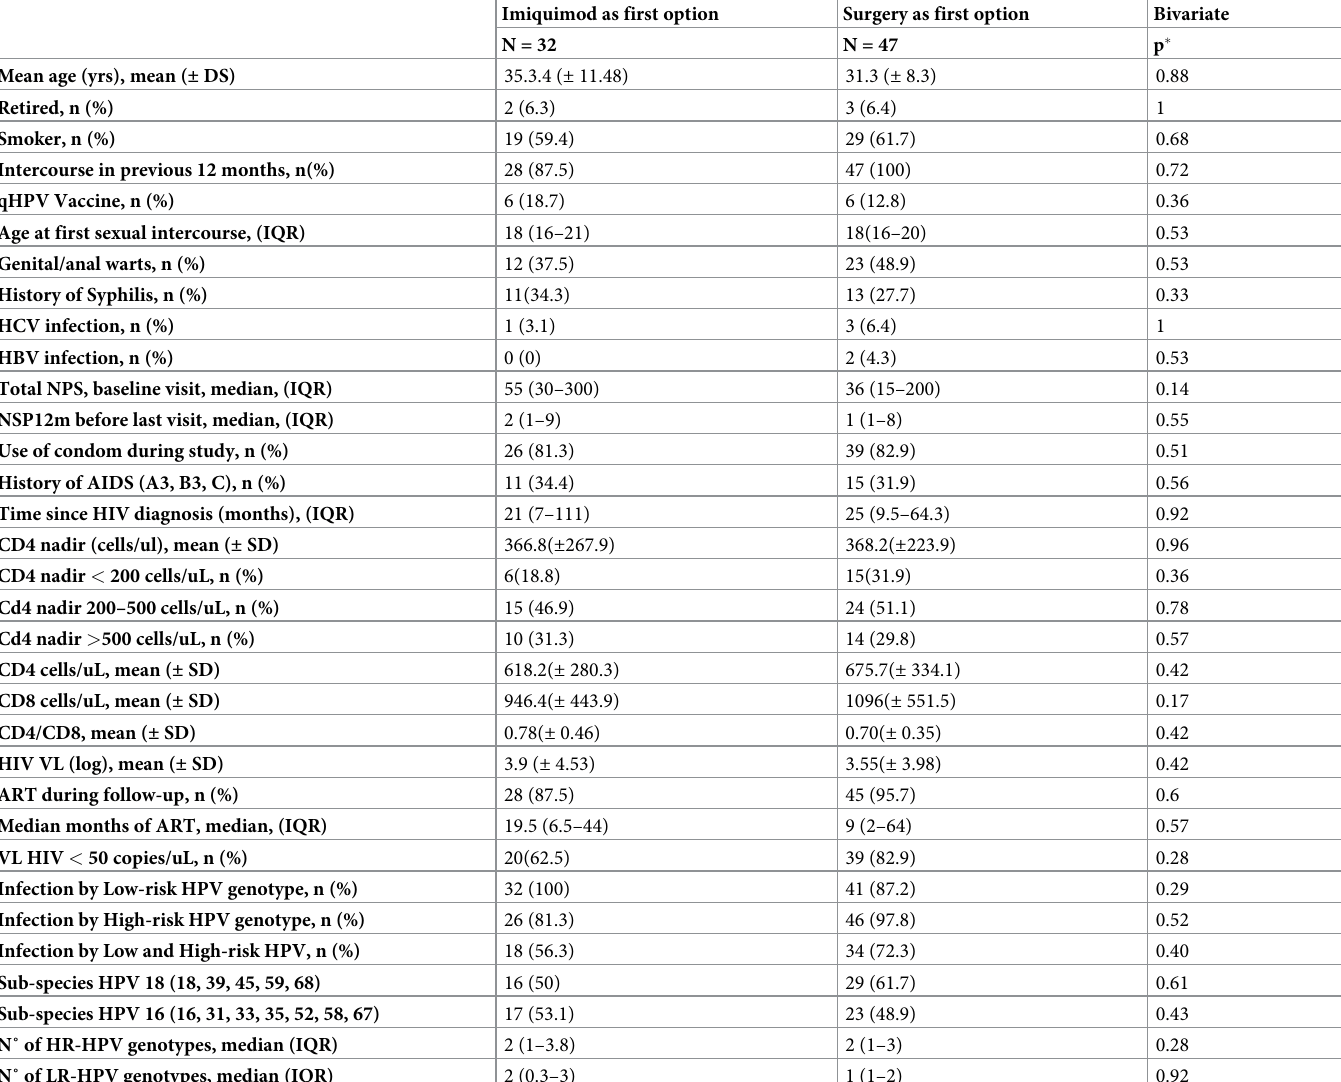
Table 4. Baseline characteristics of HIV+MSM patients receiving imiquimod vs. surgery.